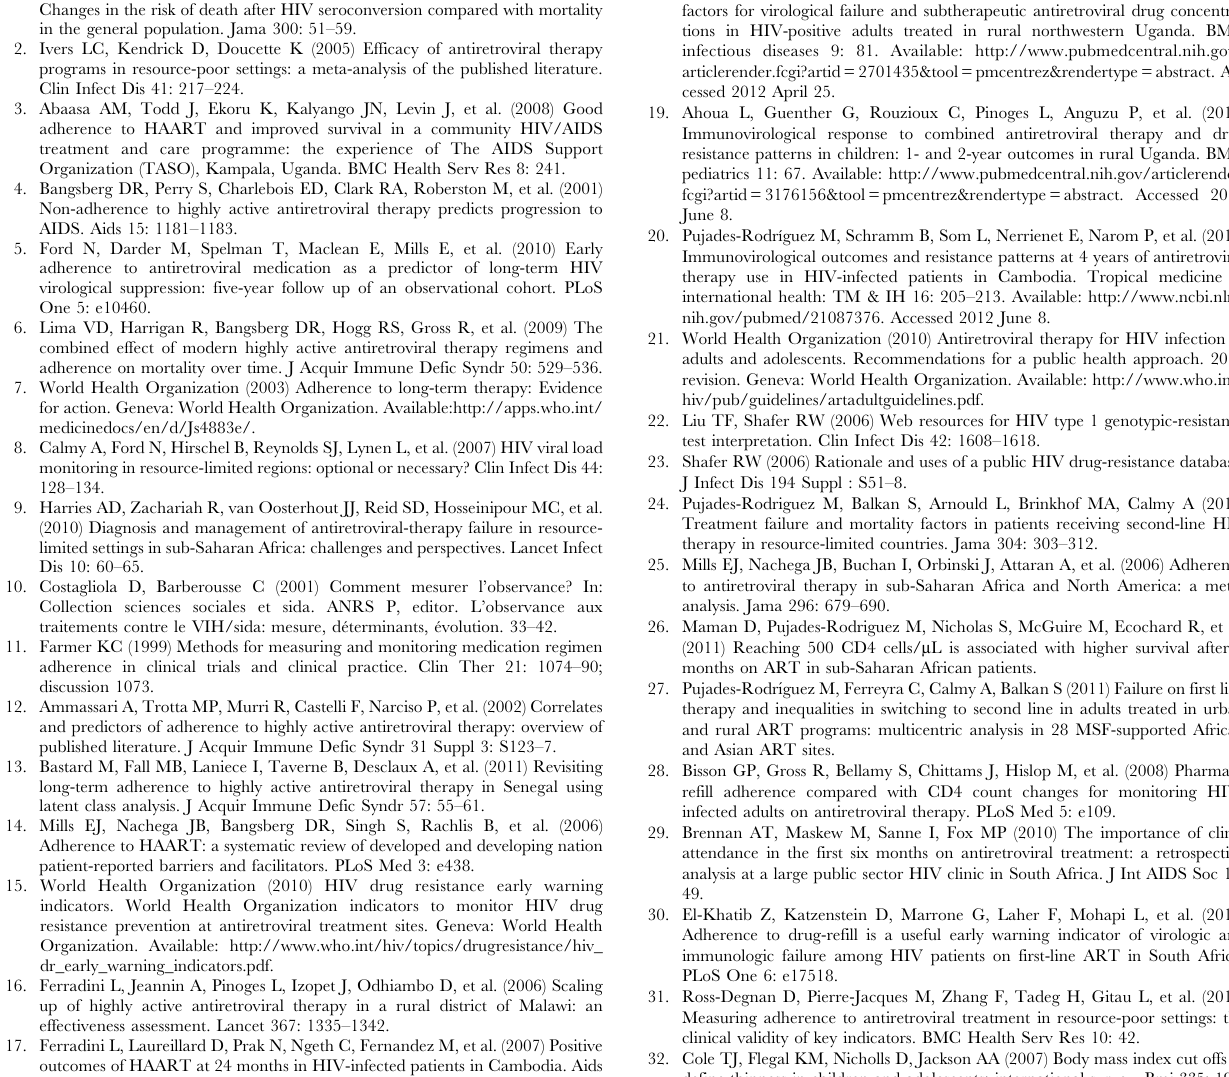
define thinness in children and adolescents: international survey. Bmj 335: